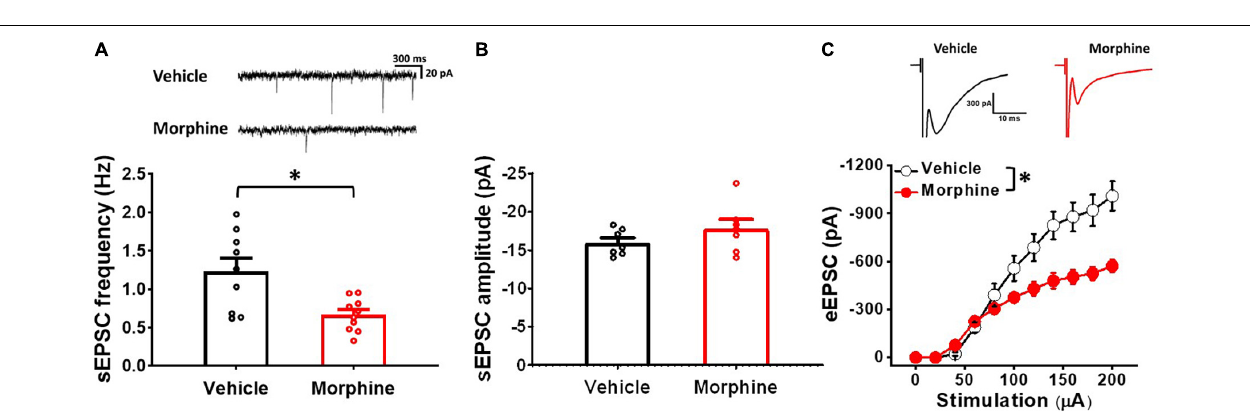
FIGURE 4 | Repeated morphine treatment decreases excitatory synaptic strength in tonic firing neurons in SDH. (A) Representative trace of tonic firing neurons. (B) (top) Representative traces of sEPSC and (bottom) sEPSC frequency (effect size:–3.44, p = 0.018; Vehicle: N = 3, n = 12; Morphine: N = 5, n = 16). ∗ p < 0.05 by Welch’s t test. (C) (top) Representative traces of eEPSC and (bottom) Stimulus-responsive curve of eEPSC [ F ( 1 , 5 . 92 ) = 25.56, p = 0.002; Vehicle ( N = 4, n = 9); Morphine ( N = 3, n = 7)]. ∗∗ p < 0.01 vs. vehicle by Sidak’s multiple comparison test following multilevel analysis.